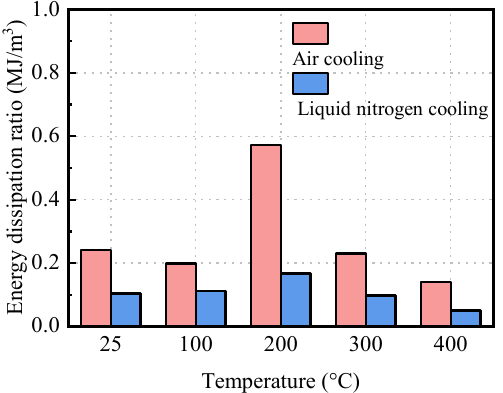
Figure 11. Effect of liquid nitrogen cooling on energy dissipation ratio.